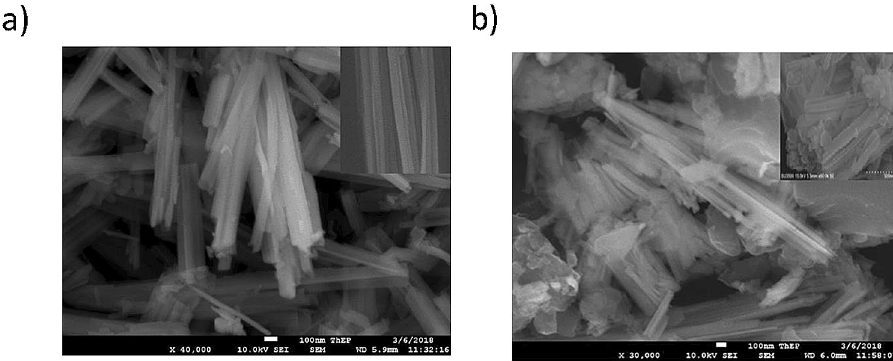
Figure 2. SEM images of ( a ) Cu(OH) 2 -NWs, and ( b ) Cu(OH) 2 -NWs-PVA-AC